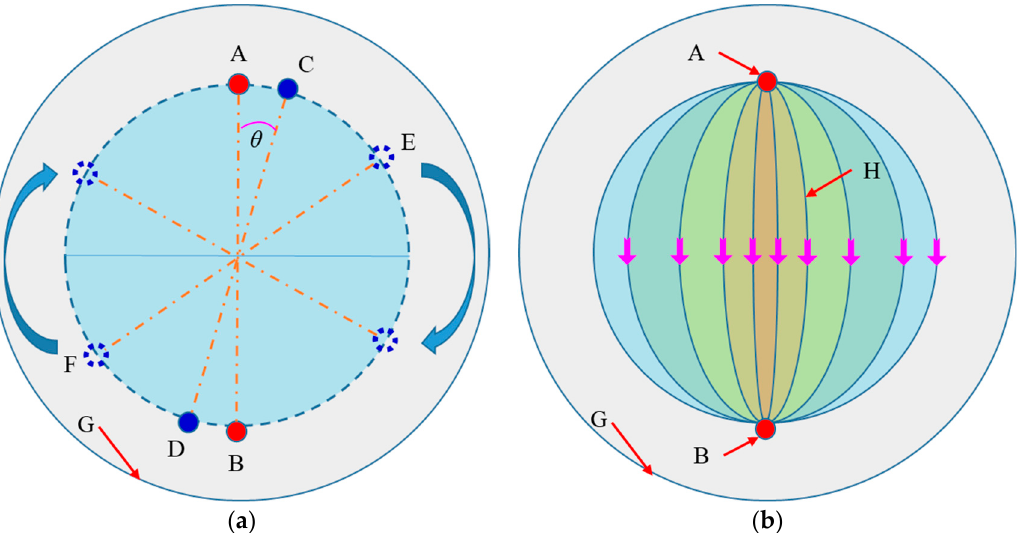
Figure 6. Schematic diagram of electrode arrangement for the water bathing experiment. A—input positive electrode; B—input negative electrode; C—receiving positive electrode; D—receiving negative electrode; E—potential position of receiving positive electrode after rotation; F—potential position of receiving negative electrode after rotation; G—solution boundary; H—electric field line diagram. ( a ) Schematic diagram of receiving electrode rotation relative to input electrodes. ( b ) Schematic diagram of electric field excited by input electrode.